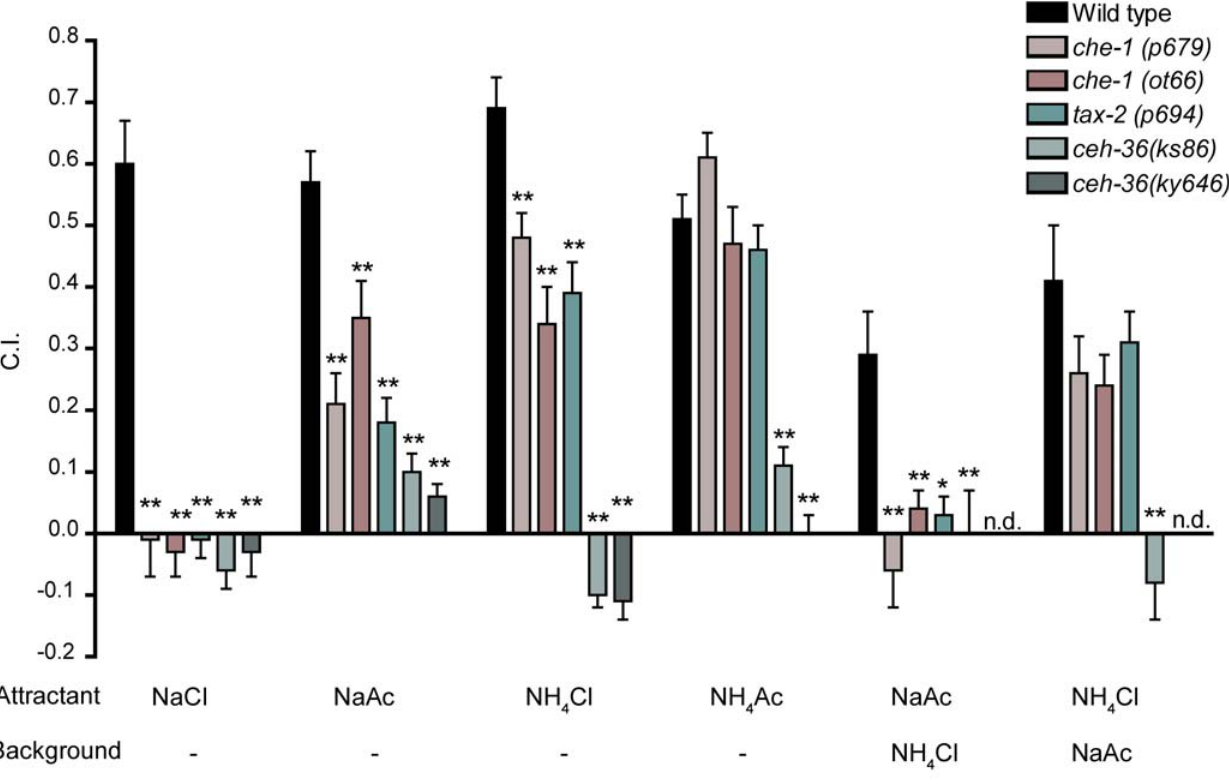
Figure 4. Genetic analysis of the relative ionic contributionsto water soluble chemotaxis assays. Attractants and uniform background compositions are indicated below each group of bars; the no-background conditions are indicated by ‘‘-’’ and n.d. means no data. Each bar represents the mean of at least 8 independent assays. Statistics: * p , 0.05 and ** p , 0.01 in a one way ANOVA and Dunnet’s post test comparing all means to the wild-type (N2)